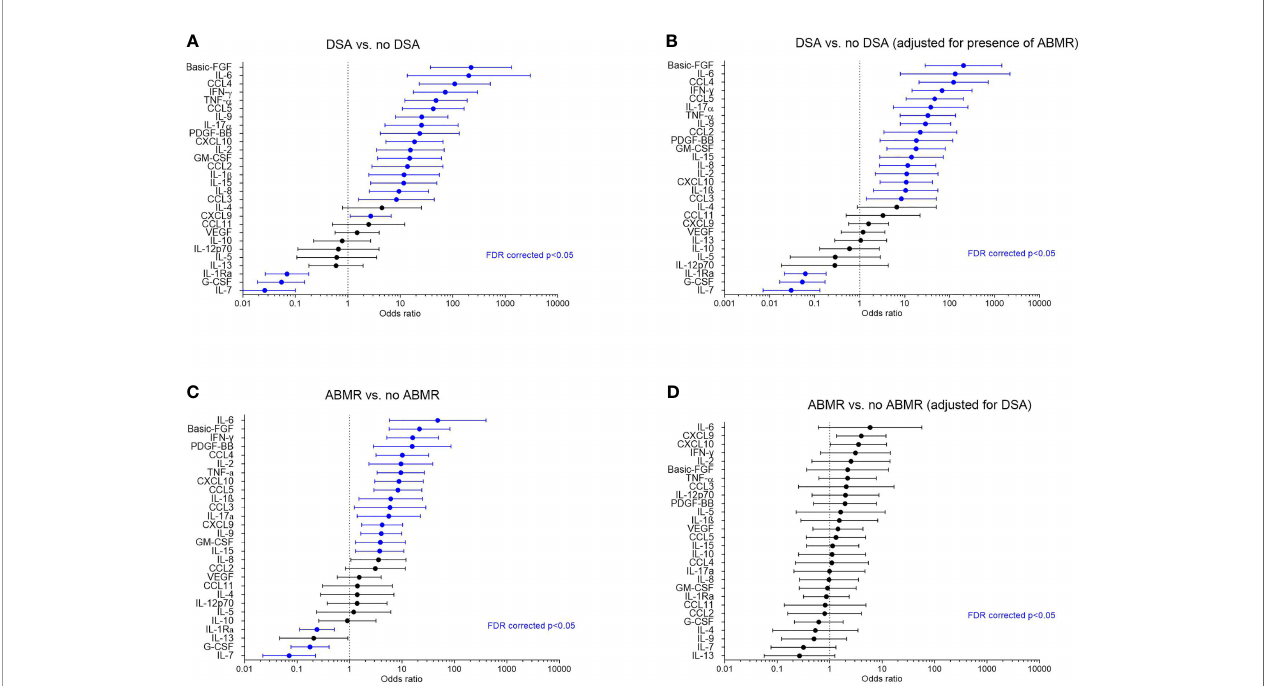
FIGURE 2 | Associations of the cytokines with HLA-DSA and antibody-mediated rejection in all samples (N = 293). (A) Forest plots of odds ratios for association of the cytokines with HLA-DSA (N = 38 vs. 255), (B) with HLA-DSA when adjusted for presence of ABMR, (C) with ABMR vs. no ABMR (N = 26 vs. N =267), and (D) with ABMR when adjusted for presence of HLA-DSA. Blue color indicates associations that were signi fi cant after false discovery rate correction (FDR p-value <0.05). ABMR, antibody-mediated rejection incl. mixed rejection; HLA-DSA, anti-HLA donor-speci fi c antibodies; FDR, false discovery